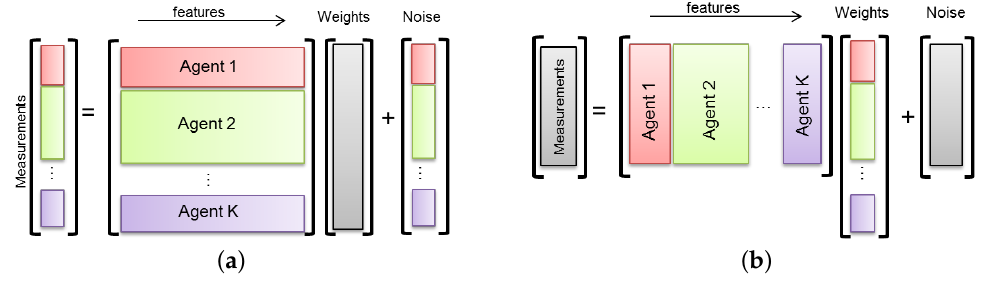
Figure 1. The colored areas represent an individual agent, and grey areas are commonly known by all agents. The matrices in these figures are arranged according to (1). ( a ) SOE learning approach: the weight vector w is commonly known by all agents; ( b ) SOF learning approach: the measurement vector y and noise vector (cid:101) are commonly known by all